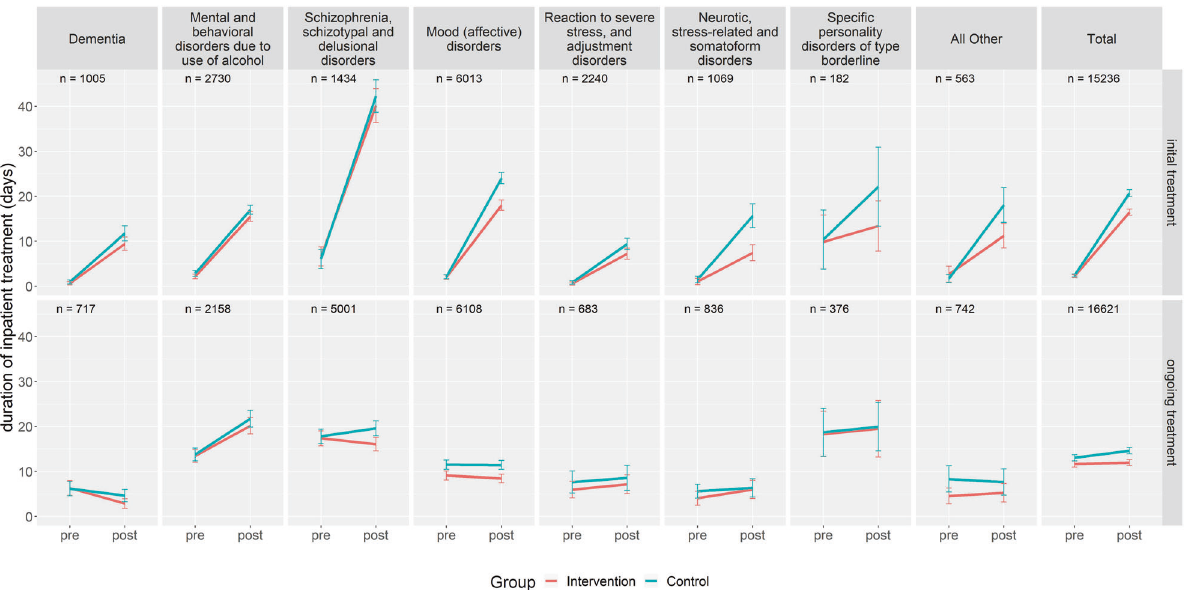
Fig. 1 Mean duration of inpatient treatment in different clusters of psychiatric disorders (adult psychiatry). Intervention = FIT hospital, Control = hospital employing routine care; pre = 1 year prior to inclusion; post = 1 year after inclusion; Initial treatment = patients that had no contact to the psychiatric ward or PIA in the corresponding FIT or control hospital in the 2 years prior to being included into the study; Ongoing treatment = patients having at least one contact to the psychiatric ward or PIA in the corresponding FIT or control hospital in the 2 years prior to being included into the